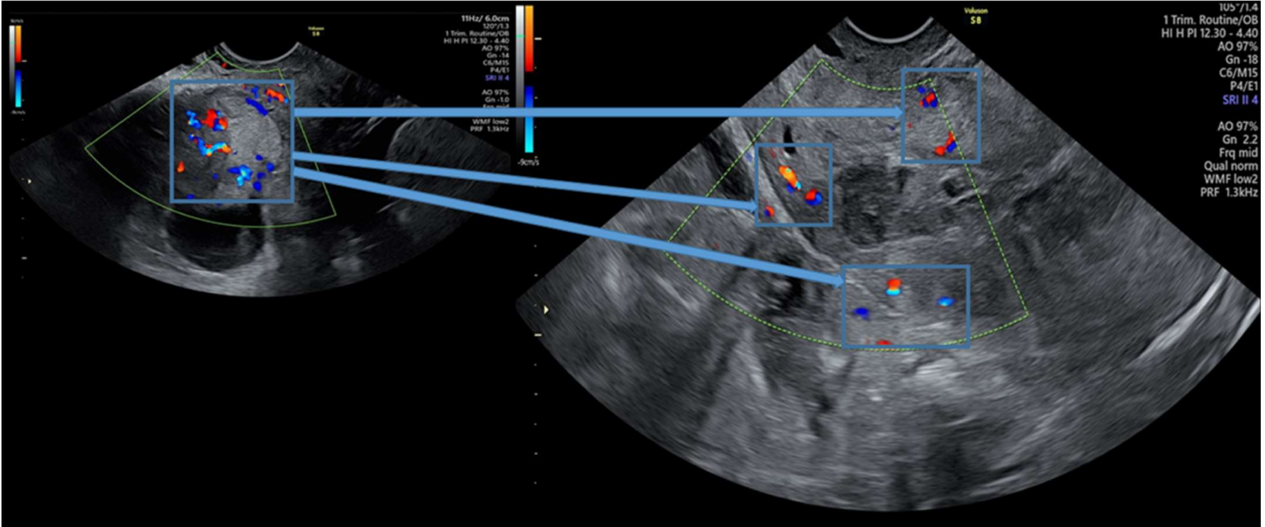
Figure 3. Doppler ultrasound before and after two steeps procedure showing the minimum residual vascularization (the areas of interest are shown post-procedure highlighted in the blue squares connected to the initial area via blue